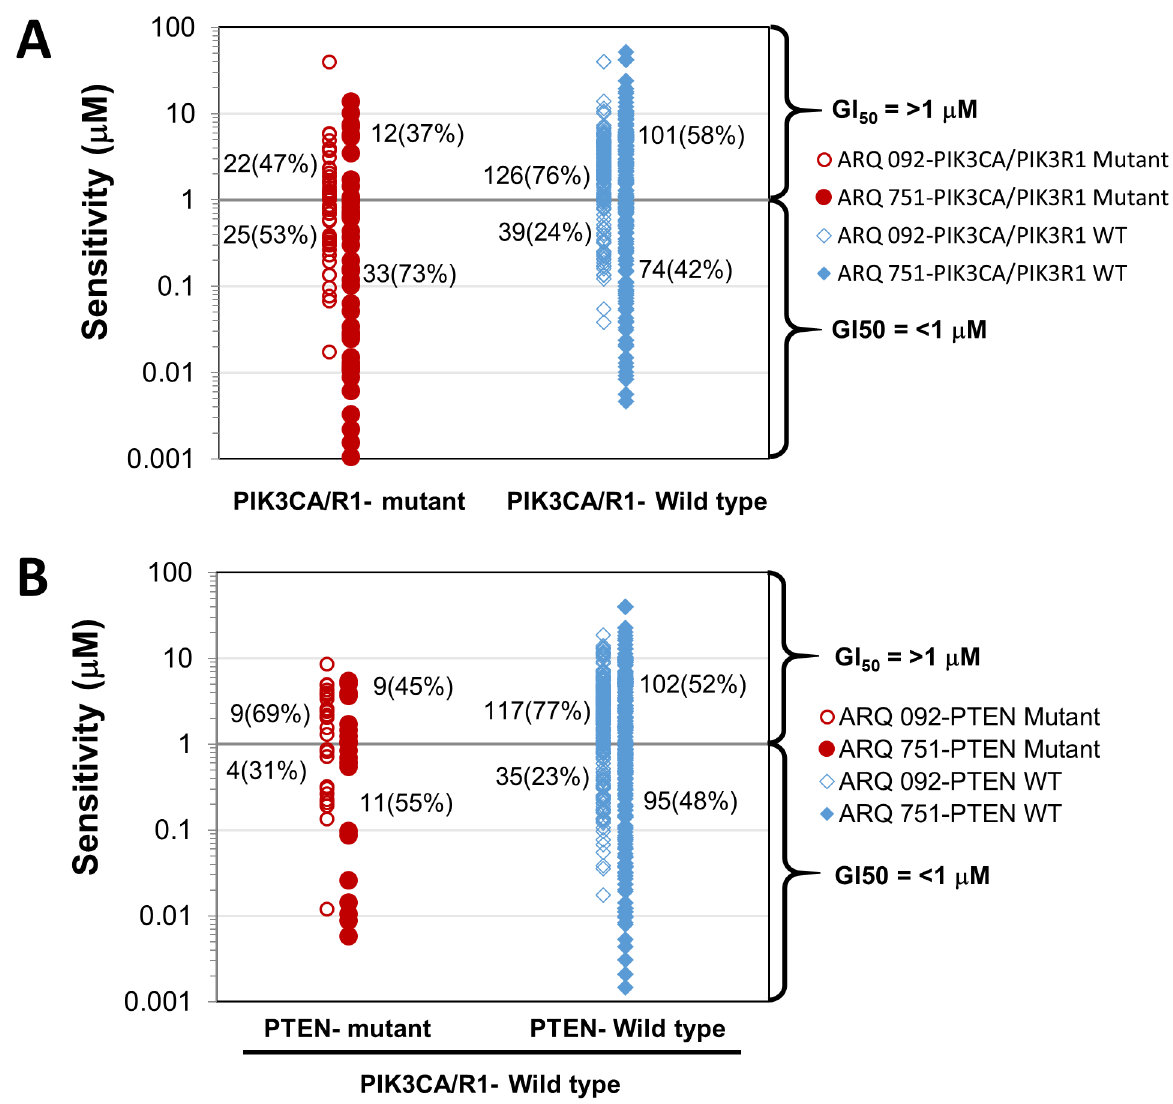
Fig 6. PIK3CA/PIK3R1 mutational status is associated with increased ARQ 092 and ARQ 751 sensitivity. Somatic mutation analysis was performed for ARQ 092 and ARQ 751 sensitive (GI 50 < 1 μ M) and resistant (GI 50 (cid:1) 1 μ M) groups for 212 cancer cell lines. Twenty-eight of 240 cells were excluded due to unavailability of mutation status. (A) Scatter plot shows the correlation between ARQ 092 and ARQ 751sensitivity and PIK3CA/R1 mutations in comparison to WT-PIK3CA/PIK3R1. (B) Scatter plot shows the correlation between ARQ 092 and ARQ 751 sensitivity and PTEN mutations in comparison to